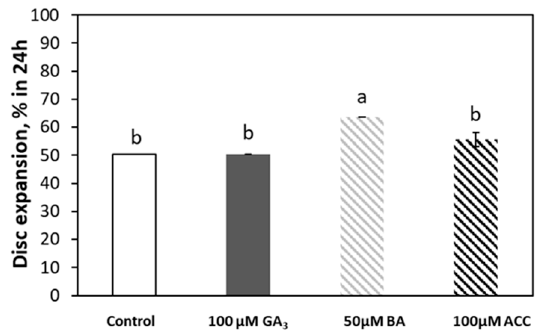
Figure 6. Area expansion of discs excised from the base of pepper leaves after incubation for 24 h on solutions of 100 µM GA 3 , 50 µM BA and 100 µM ACC. Bars are the mean ± SE of 10 replicates. Different letters indicate significant ( p < 0.05) differences between treatments.